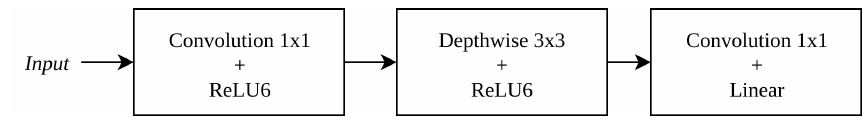
Figure 3. MobileNet v2